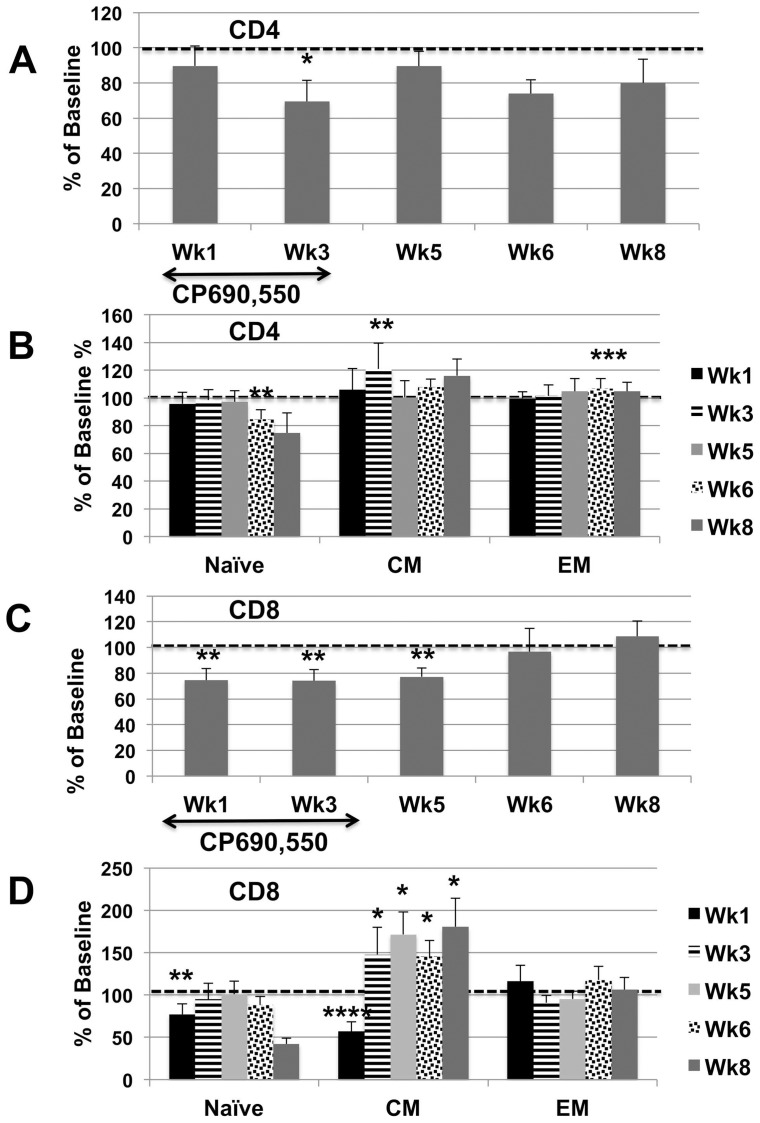
The effect of JAK3 oral administration on the frequencies of CD4+ and CD8+ T cells and their subsets in 6 SIV chronically infected rhesus macaques.Each animal received an initial loading does of 20 mg/kg and thereafter a daily dose of 10 mg/kg for a total of 35 days. A) Aliquots of the PBMC obtained prior to (baseline) and at weeks 1, 3, 5, 6, 8 and 12 were analyzed for the frequencies of lymphoid cell subsets A) The mean % change from baseline values of CD4+ T cells is shown. B) The mean % change from baseline values of CD4+ T cells classified as naïve, central memory (CM) and effector memory (EM) is illustrated c) The mean % change from baseline of total CD8+ T cells is shown and D) The mean % change from baseline values of CD8+ T cells classified as naïve, central memory (CM) and effector memory (EM) is illustrated. Statistical differences are denote as asterisks with * (p<0.01), ** (p<0.05), *** (p<0.03) and **** (p<0.001).